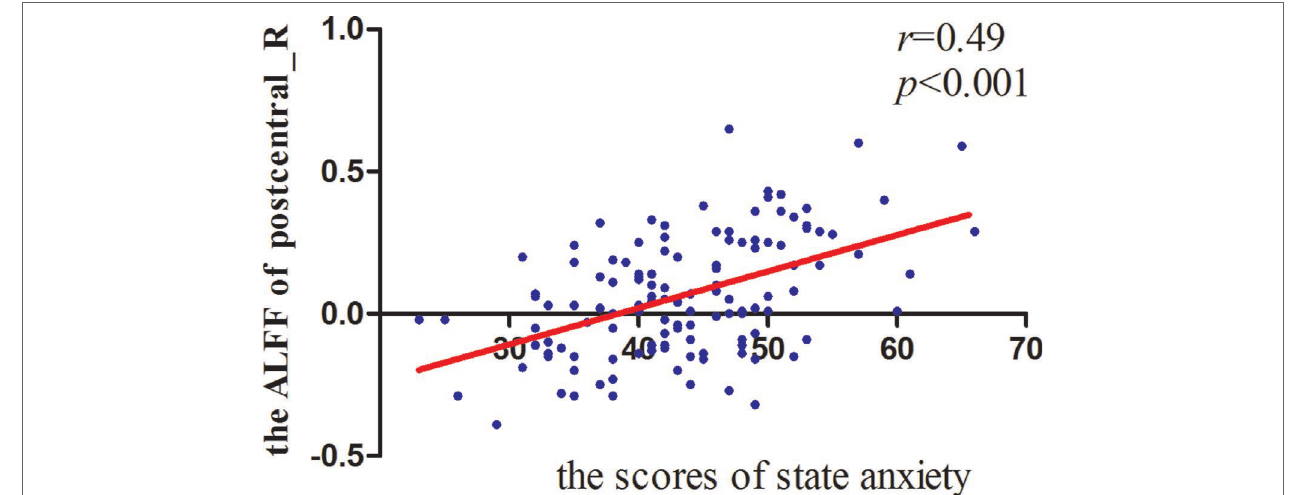
FIGURE 3 | Correlation between right postcentral gyrus signals and state